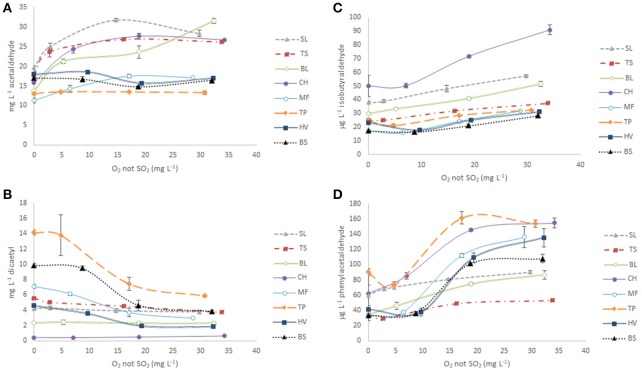
Evolution of the amounts of total aldehydes present in each wine exposed to different levels of oxygen. The X axis represents the amount of O2 consumed not invested in the oxidation of wine SO2 (O2
not SO2). (A) Acetaldehyde, (B) diacetyl, (C) isobutyraldehyde, and (D) phenylacetaldehyde.